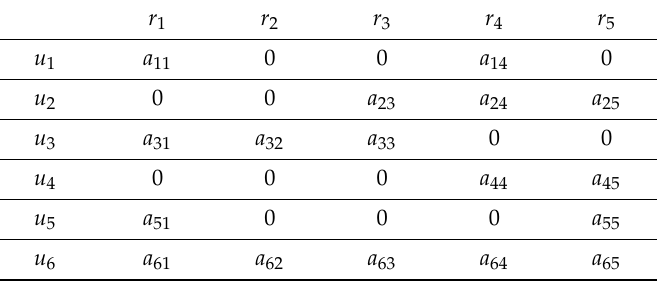
Table 11. Initialization for matrix UA’ .